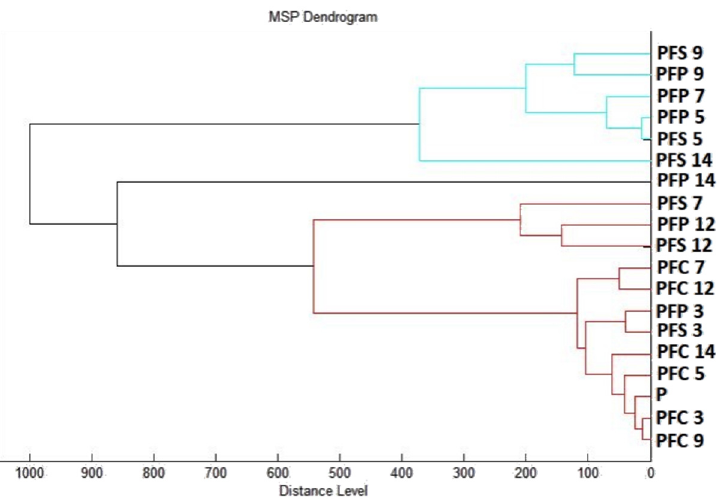
Figure 8. A dendrogram of P. fluorescens was generated using the MSPs of planktonic cells and the control. PF, P. fluorescens ; C, control; S, stainless steel; P, plastic; and only P, planktonic cells.